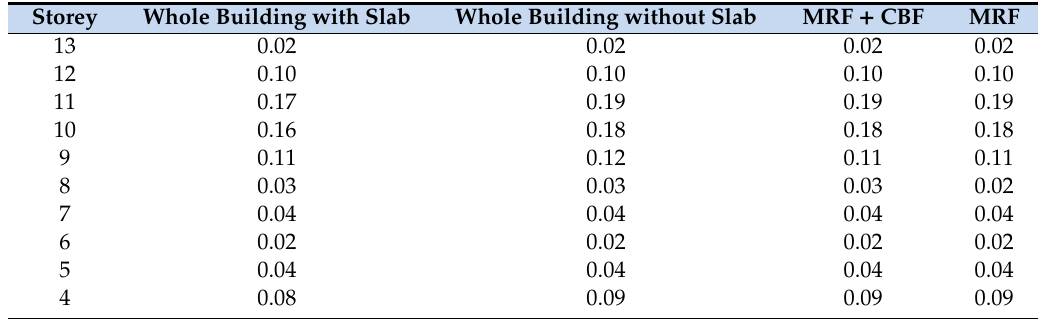
Table 7. Residual inter-storey drift for KHC and IHC models for the ULS case (%). Storey Whole Building with Slab Whole Building without Slab